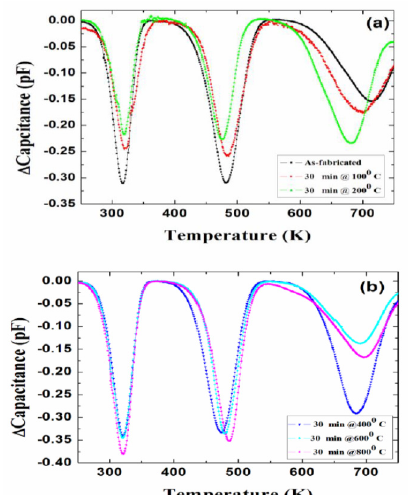
Figure 23. DLTS spectra obtained in a temperature range 250–750 K: ( a ) as-fabricated and annealed at 100 and 200 °C; and ( b ) annealed at 400, 600, and 800 °C.